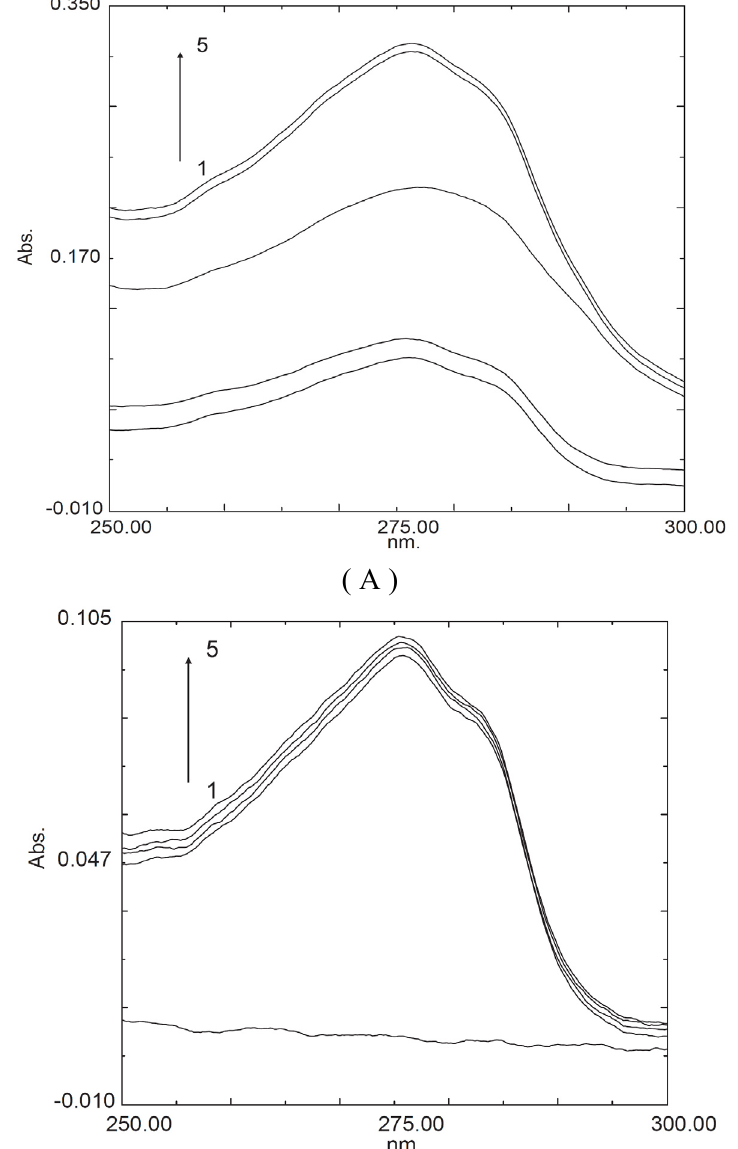
Figure 6. UV absorption spectra of insulin in different solutions. Curves 1-5 in (A) represent insulin, Insulin (100 μ g/mL) + HP- β -CD (1 mg/mL), Casein (200 μ g/mL), Insulin (100 μ g/mL) + Casein (200 μ g/mL), Insulin (100 μ g/mL)+ Casein (200 μ g/mL) + HP- β -CD (1 mg/mL), respectively; Curves 1-5 in (B) represent protamine (200 μ g/mL), insulin (100 μ g/mL), insulin (100 μ g/mL) + protamine (200 μ g/mL), insulin (100 μ g/mL) + protamine (200 μ g/mL) + HP- β -CD (1 mg/mL), insulin (100 μ g/mL) + HP- β -CD (1 mg/mL),